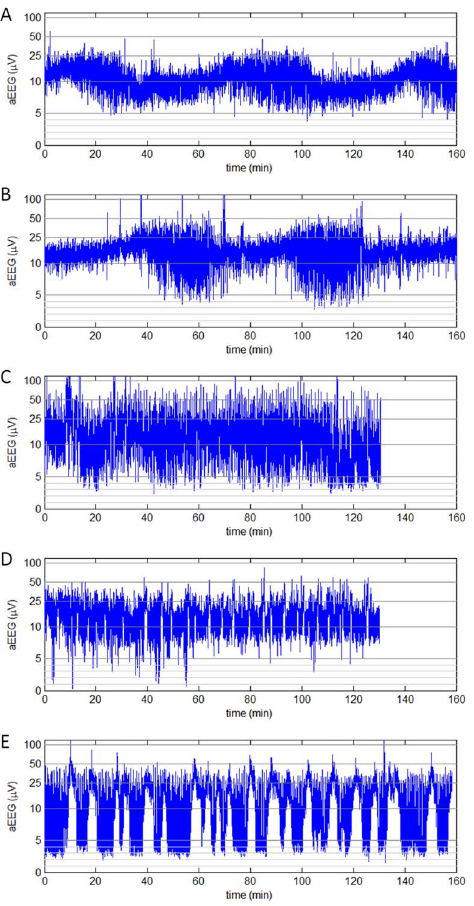
Figure 1. Characteristic appearance of aEEG tracings with different scores of background pattern, cyclicity, and seizure activity. A , background pattern=0, cyclicity=0, seizure activity=0; postmenstrual age (PMA)=39 weeks + 6 days. B , background pattern=0, cyclicity=0, seizure activity=0; PMA=39w + 4. C , background pat- tern=1, cyclicity=0, seizure activity=0; PMA=37w + 3. D , background pattern=0, cyclicity=1, seizure activity=1; PMA=43w + 2. E , back- ground pattern=2, cyclicity=2, seizure activity=2; PMA=39w + 6.